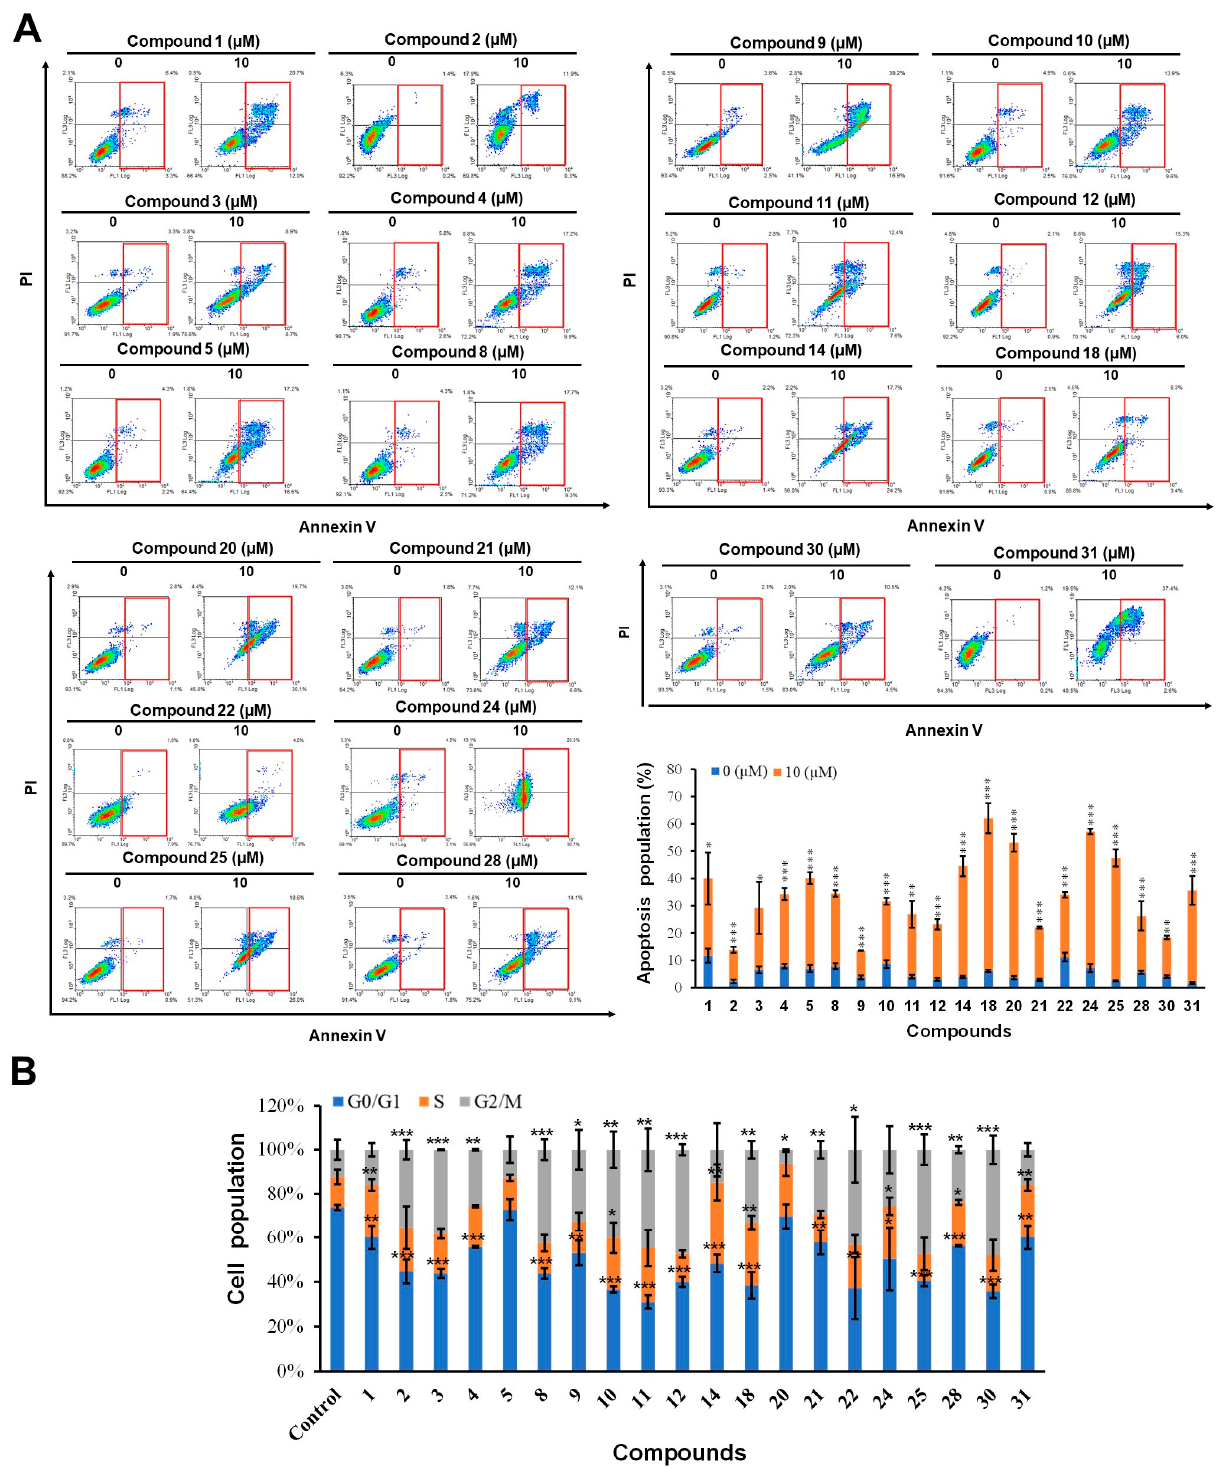
Figure 3. Apoptosis induction and cell cycle effects of compounds in HCT-116 cells. ( A ) The apoptotic population of HCT-116 cells was analyzed using flow cytometry after treatment with 10 µ M of the test compound for 24 h followed by Annexin V/propidium iodide (PI) staining. ( B ) After treatment with compound concentrations of 10 µ M for 24 h, cells were fixed, stained with propidium iodide (PI), and analyzed for cell cycle distribution. Results are expressed as the means ± SD from three independent experiments (* p < 0.05 and ** p < 0.01 *** p < 0.001, control versus compound).